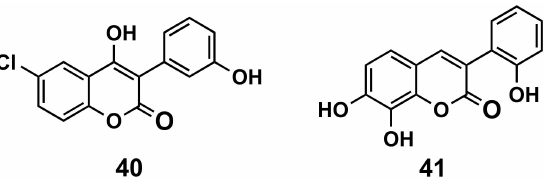
Figure 18. 3-Phenylcoumarins as antiparasitic